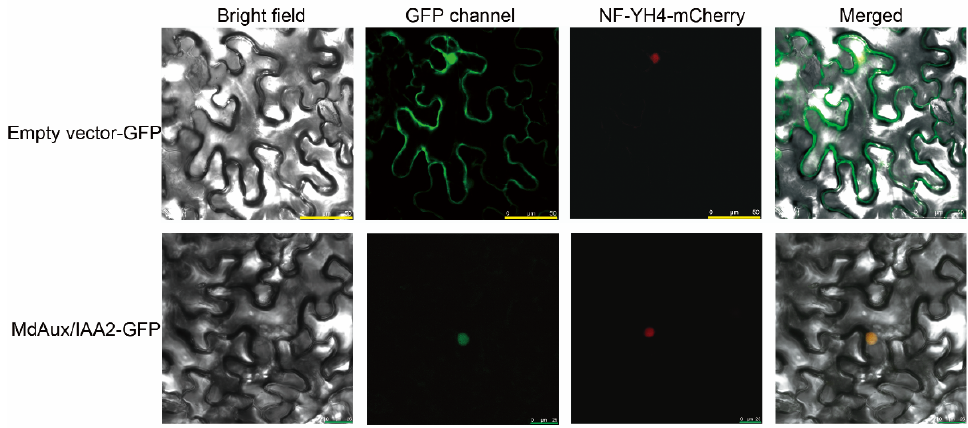
Figure 3. Subcellular localization of MdAux/IAA2. NF-YA4-mCherry was the nuclear marker. MdAux/IAA2-GFP was MdAux/IAA2, which was connected to the carrier of PRI101 containing the GFP label. The empty vector-GFP was the control. The empty vector-GFP yellow scale was 50 μ m, and the MdAux/IAA2-GFP green scale was 25 μ m.